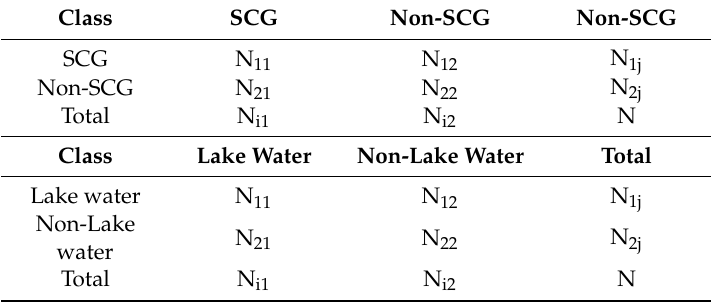
Table 3. ConfusionmatrixofsamplepointsN ij . Classifiedbinaryimagesareinrowsandthecorresponding reference points are in columns. N 11 , N 12 , N 21 , N 22 are the sample counts between classified binary image and reference